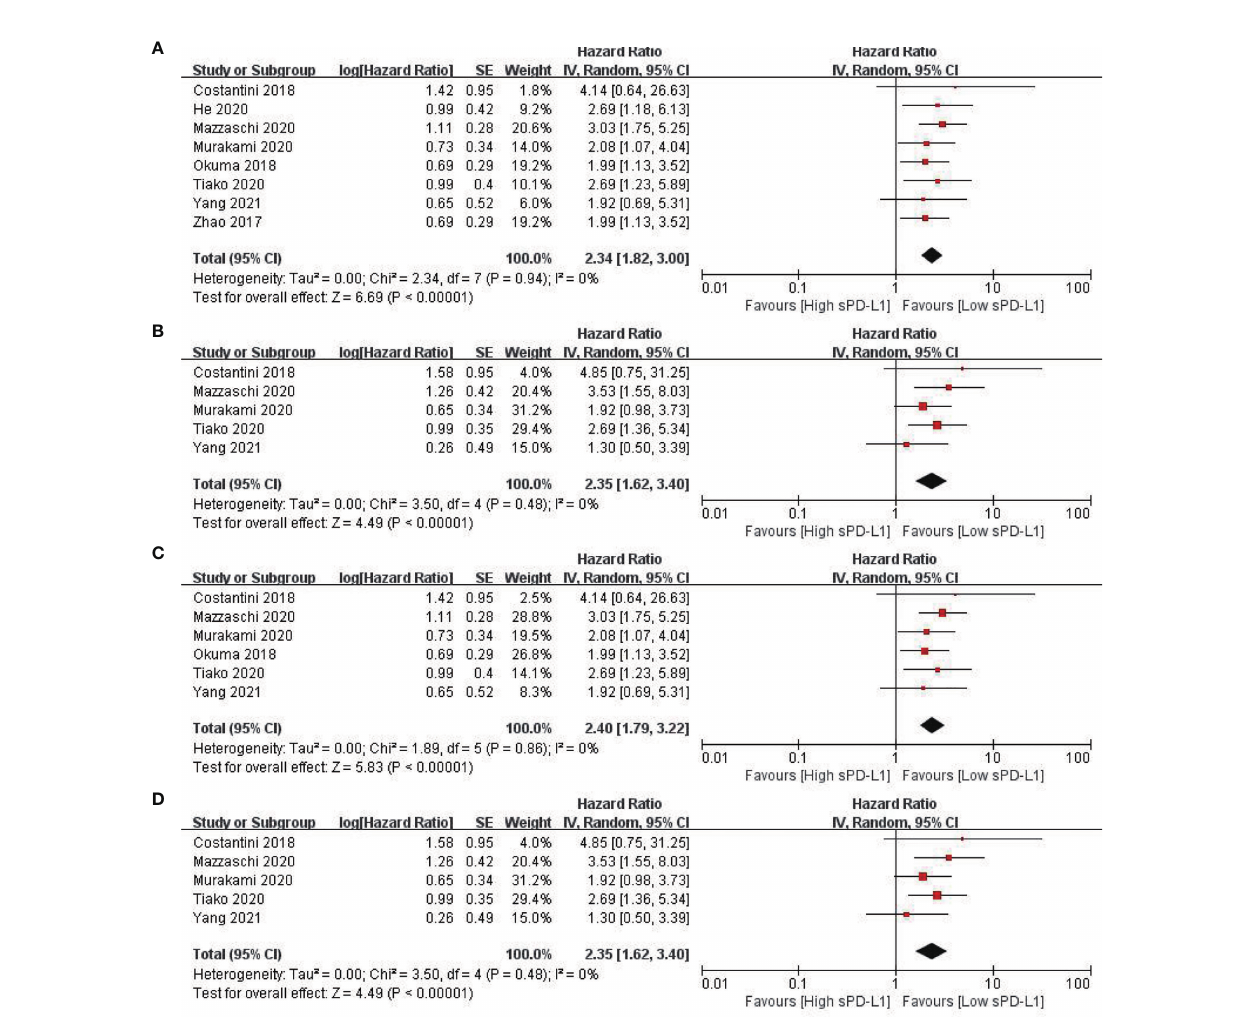
FIGURE 2 | Forest plots of hazard ratio for the relationship between sPD-L1 level and survival outcomes. (A) Overall survival (OS) in patients with non-small cell lung cancer. (B) Progression-free survival (PFS) in patients with non-small cell lung cancer. (C) OS in patients with non-small cell lung cancer receiving immune checkpoint inhibitors. (D) PFS in patients with non-small cell lung cancer receiving immune checkpoint